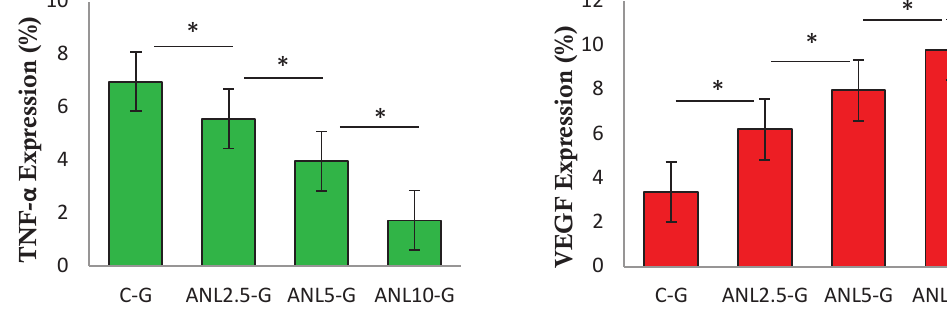
Figure 2. Mann Whitney analysis on TNF- α and VEGF Expression in four Groups. Note: * p < 0.05